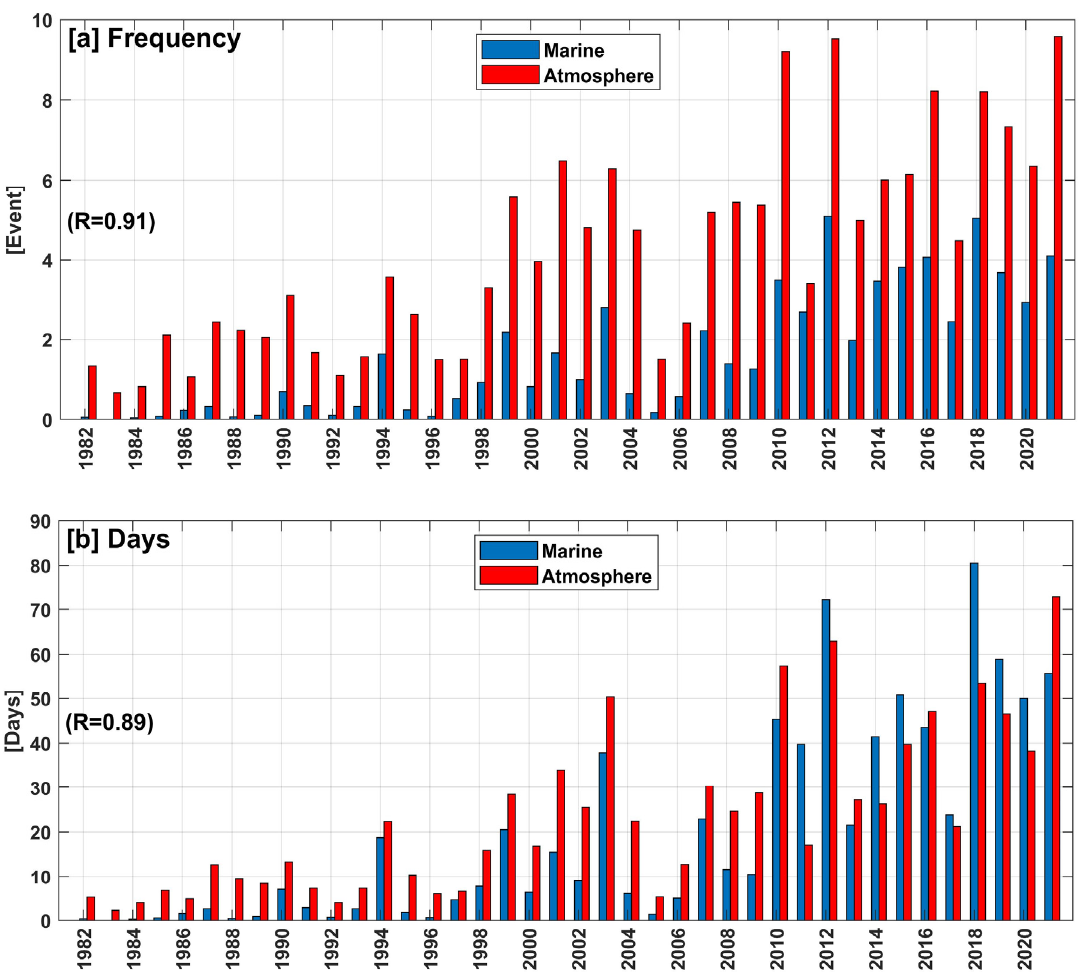
Figure 3. Temporal evolution of AHWs (red bars) and MHWs (blue bars) for ( a ) frequency and ( b ) total days over the entire EMED during 1982–2021.